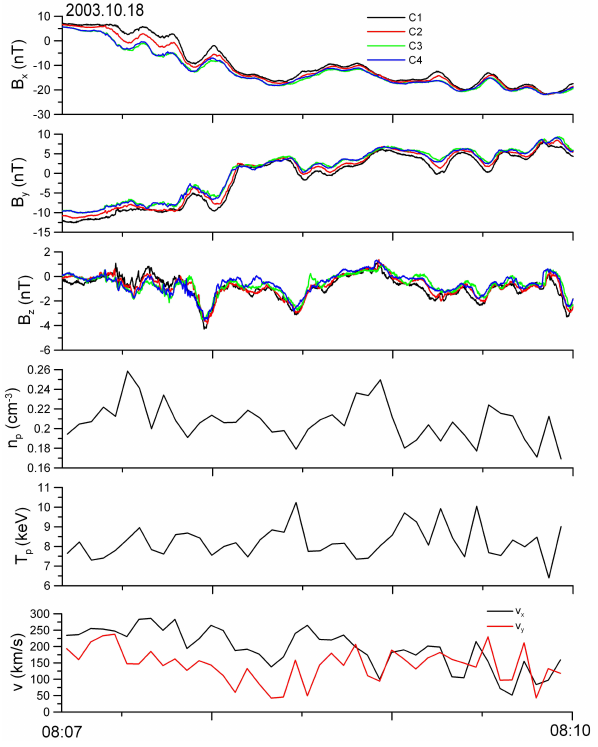
Fig. 6. Magnetic field components, proton density, temperature, velocity for the case 18 October 2003 (#16).